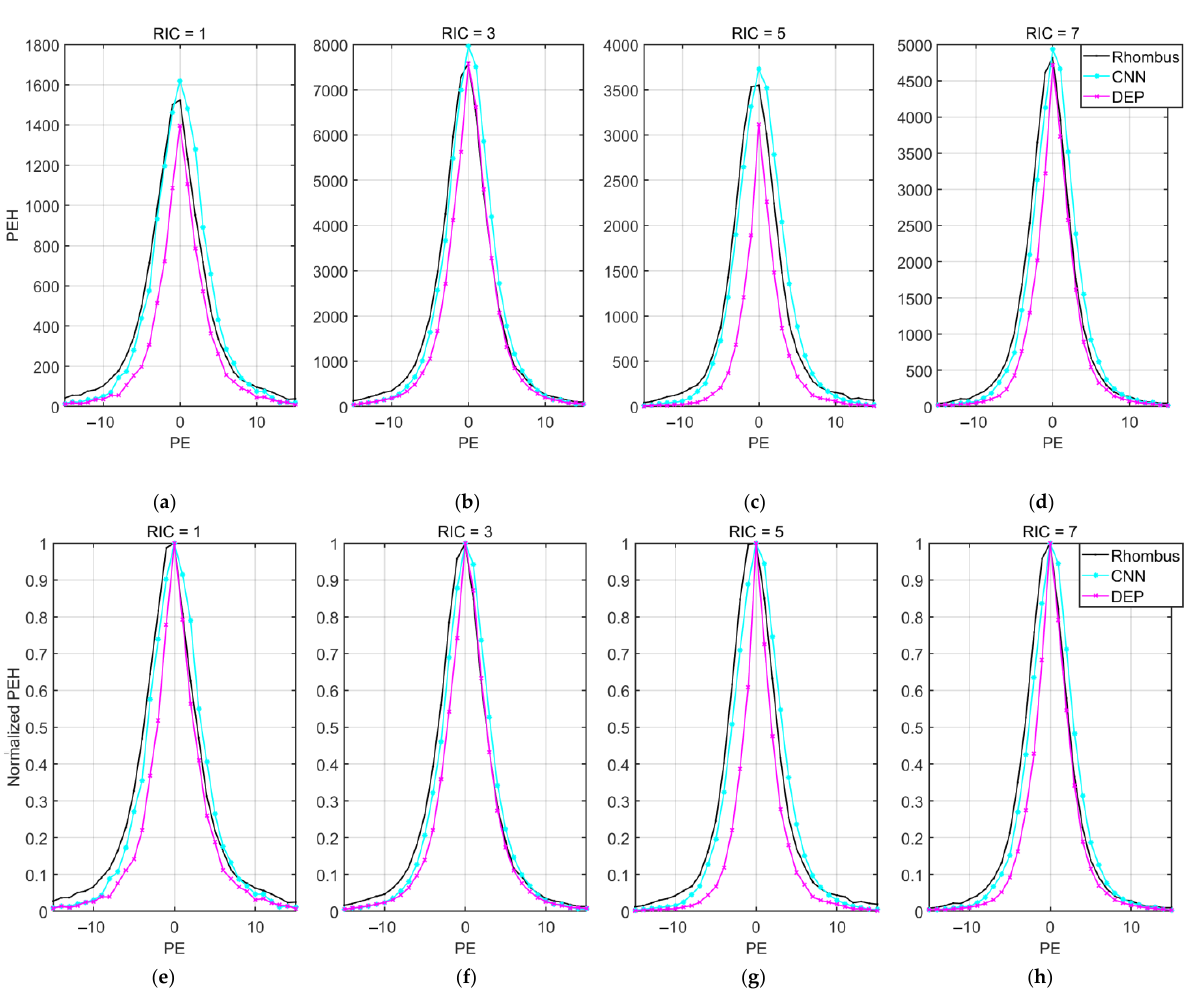
Figure 3. Comparison of PEH distribution obtained using rhombus, DEP, and CNN from the shadow layer of typical image Lena: ( a ) RIC = 1; ( b ) RIC = 3; ( c ) RIC = 5; ( d ) RIC = 7; ( e – h ) the normalized version for ( a – d ), respectively.